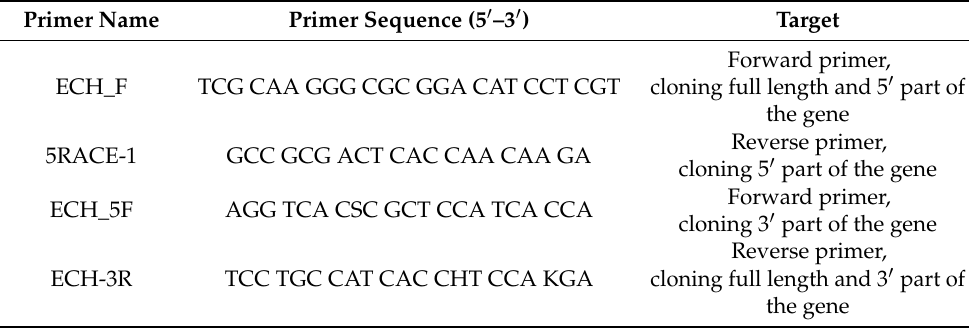
Table 1. List of primers used to amplify different parts of the ALS gene and their